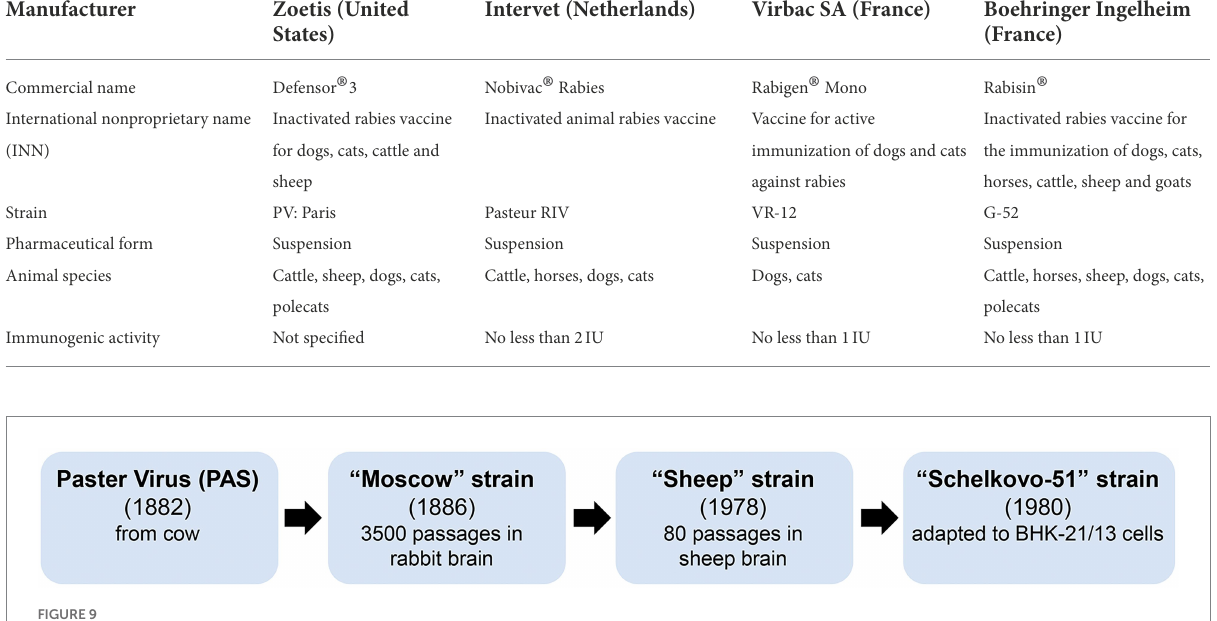
FIGURE 9 Generation of manufacturing rabies virus strains used in Russian rabies